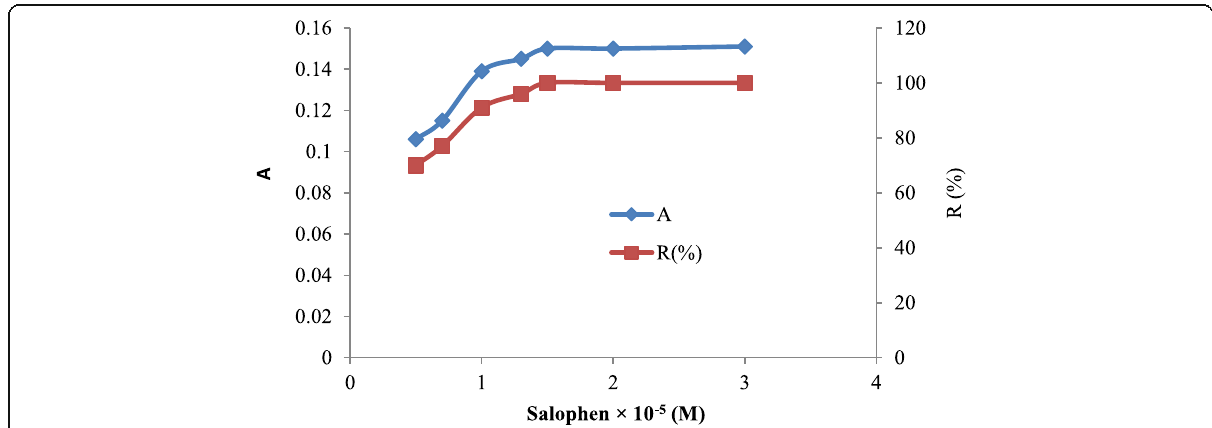
Fig. 6 Effect of salophen concentration on the extraction of Cu(II) ions by DLLME method. Conditions: sample volume, 10.0 mL; Cu(II), 50.0 μ g L − 1 ; extraction solvent (chloroform) volume, 120 μ L; disperser solvent (acetone) volume, 1.68 mL; diluting solvent (ethanol) volume, 130 μ L; centrifuge time, 5 min (at 5000